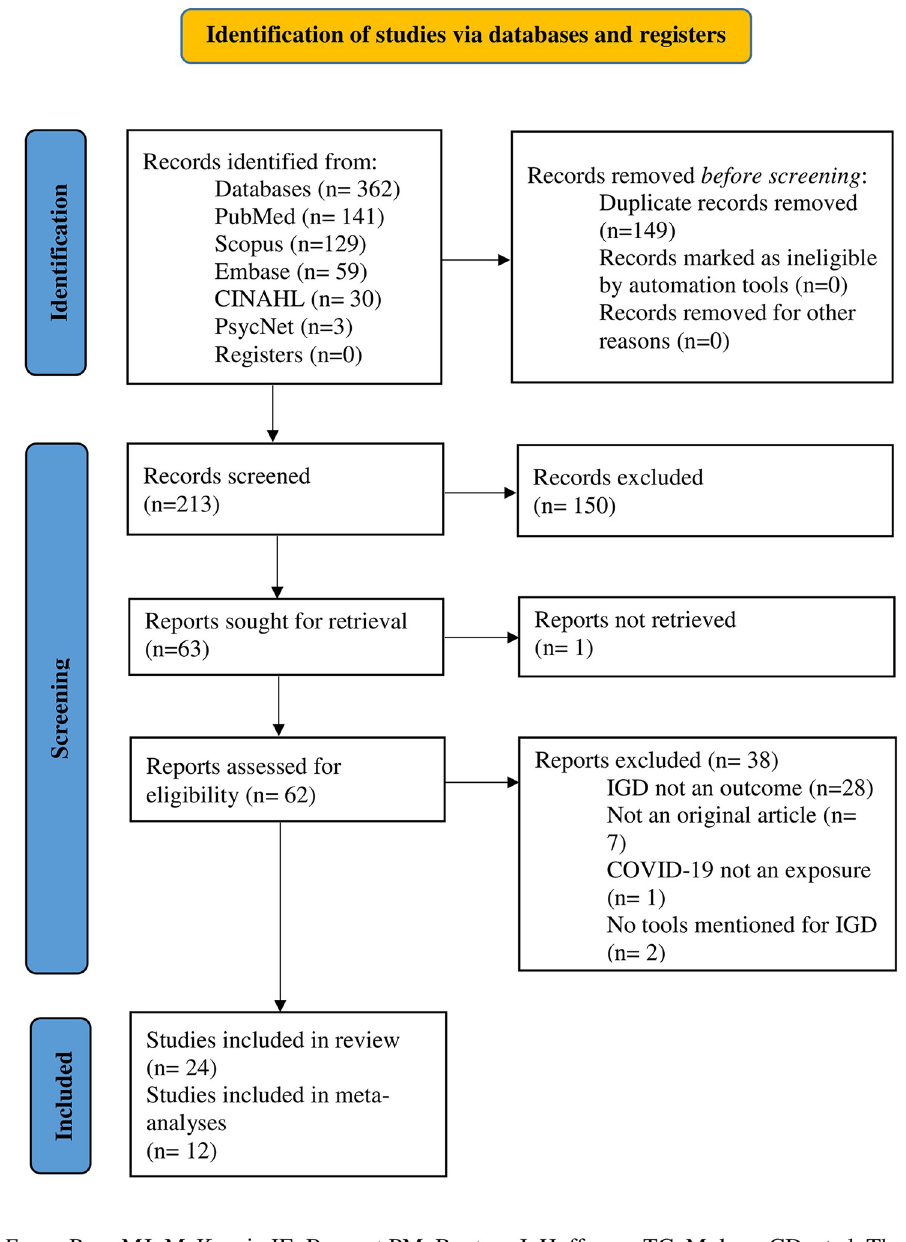
Fig 1. PRISMA flowchart of the included